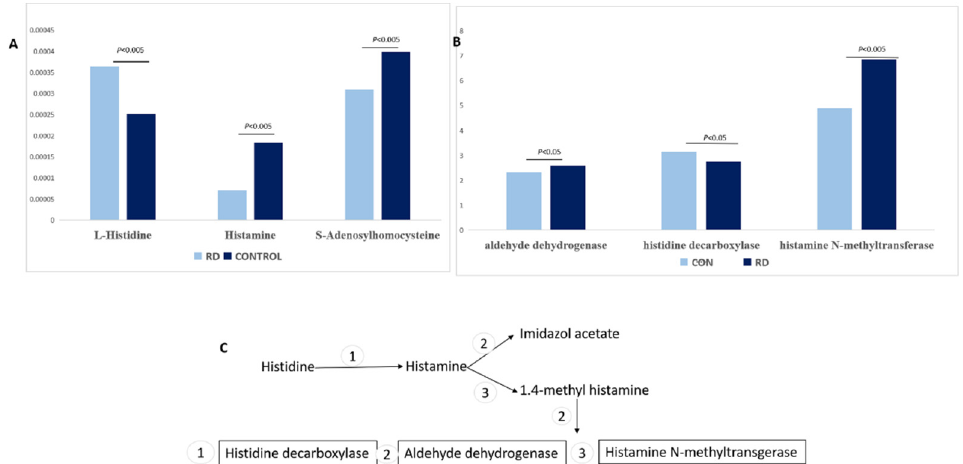
Figure 6. The alternations of histidine metabolism and pathways. ( A ) The alternations in histidine metabolomics by untargeted metabolomics. ( B ) The gene alternations of the histidine metabolomic pathway after RD. ( C ) The summarized pathway of histidine metabolomics, 1 stands for histidine decarboxylase, L-histamine could be catalyzed by histidine decarboxylase, 2 stands for aldehyde dehydrogenase, histamine could be oxidated to imidazoleacetic acid and changed to Imidazol acetate by Aldehyde dehydrogenase, 3 stands for histamine N-methyltransgerase, released histamine is degraded to 1,4-methyl imidazoleacetic acid and it could be changed to 1,4-methylimidazol acetate by Aldehyde dehydrogenase.